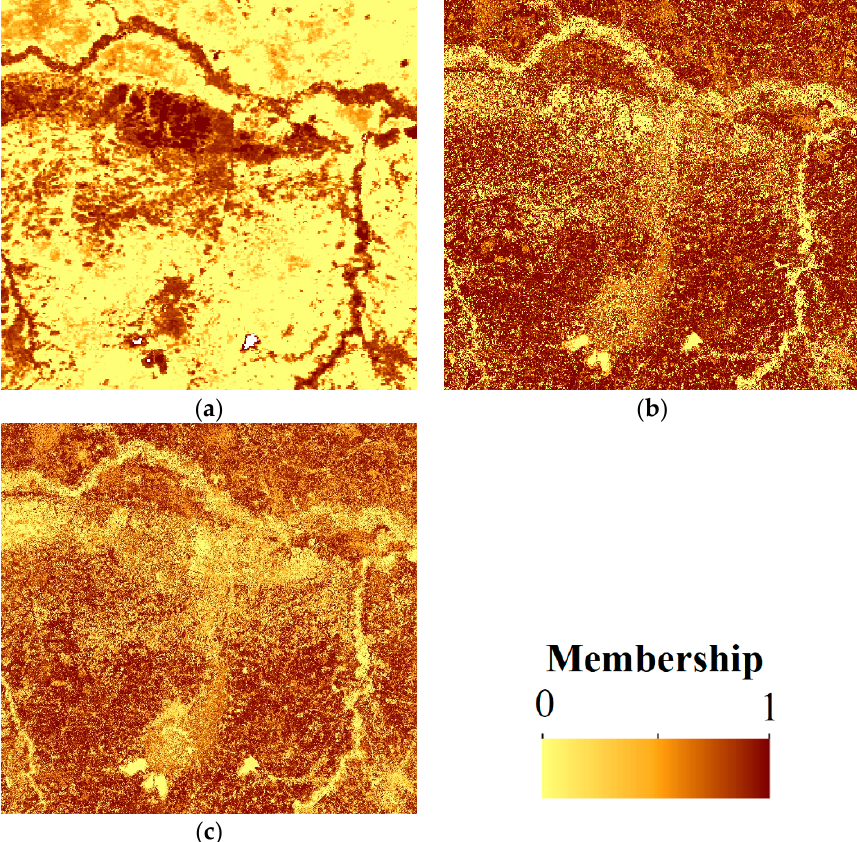
Figure 6. Possibility maps: ( a ) shows the membership values for the paddy rice class given by the Euclidean-based similarity measure from the MODIS NDVI time series while ( b , c ) show the class probability of the paddy rice class obtained by the nearest neighbor-based fuzzy classification of Landsat data at the object level and the pixel level, respectively.